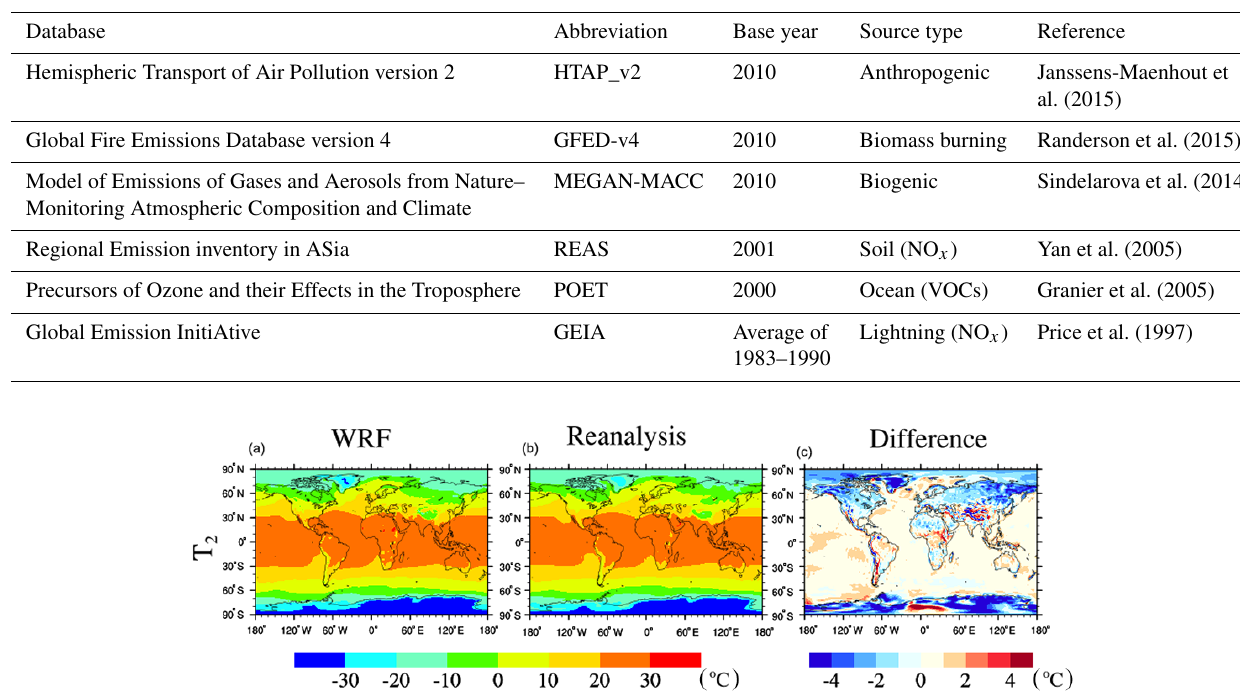
Table 1. Emissions used in the IAP-AACM. (VOCs refer to volatile organic compounds).